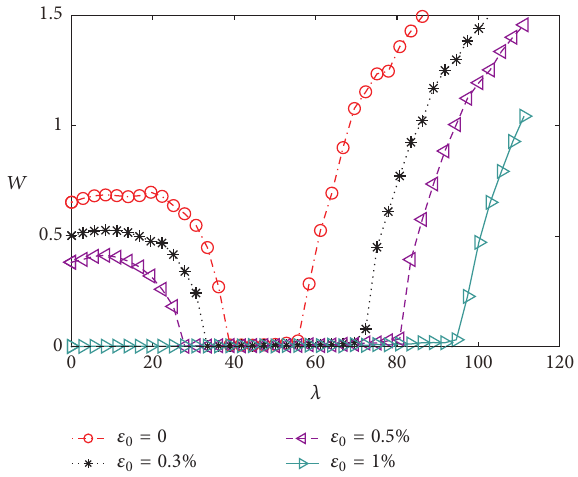
Figure 21: Influence of 𝜀 0 on buckling, flat, and flutter